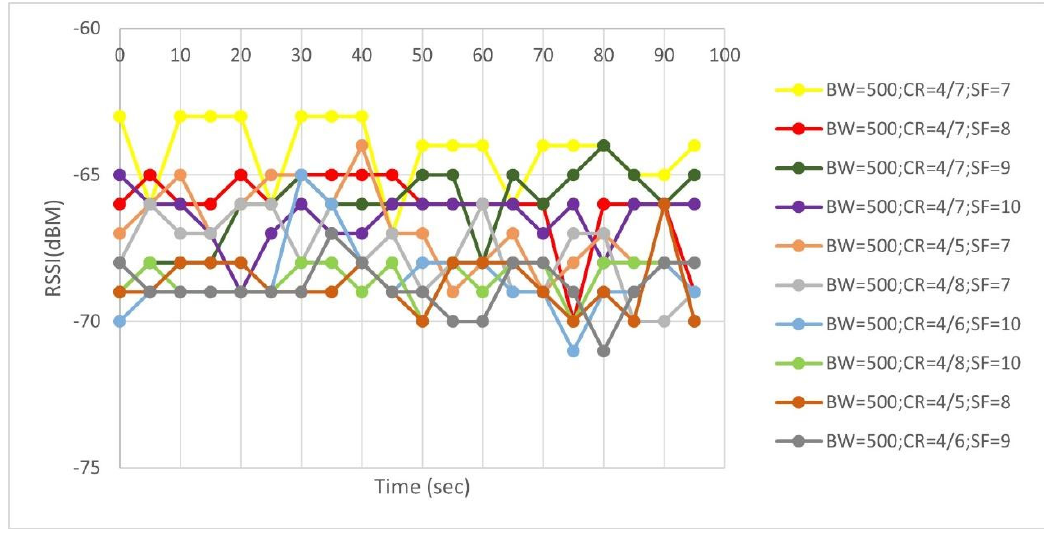
Figure 9. RSSI values for the best 10 settings in Experiment 2.